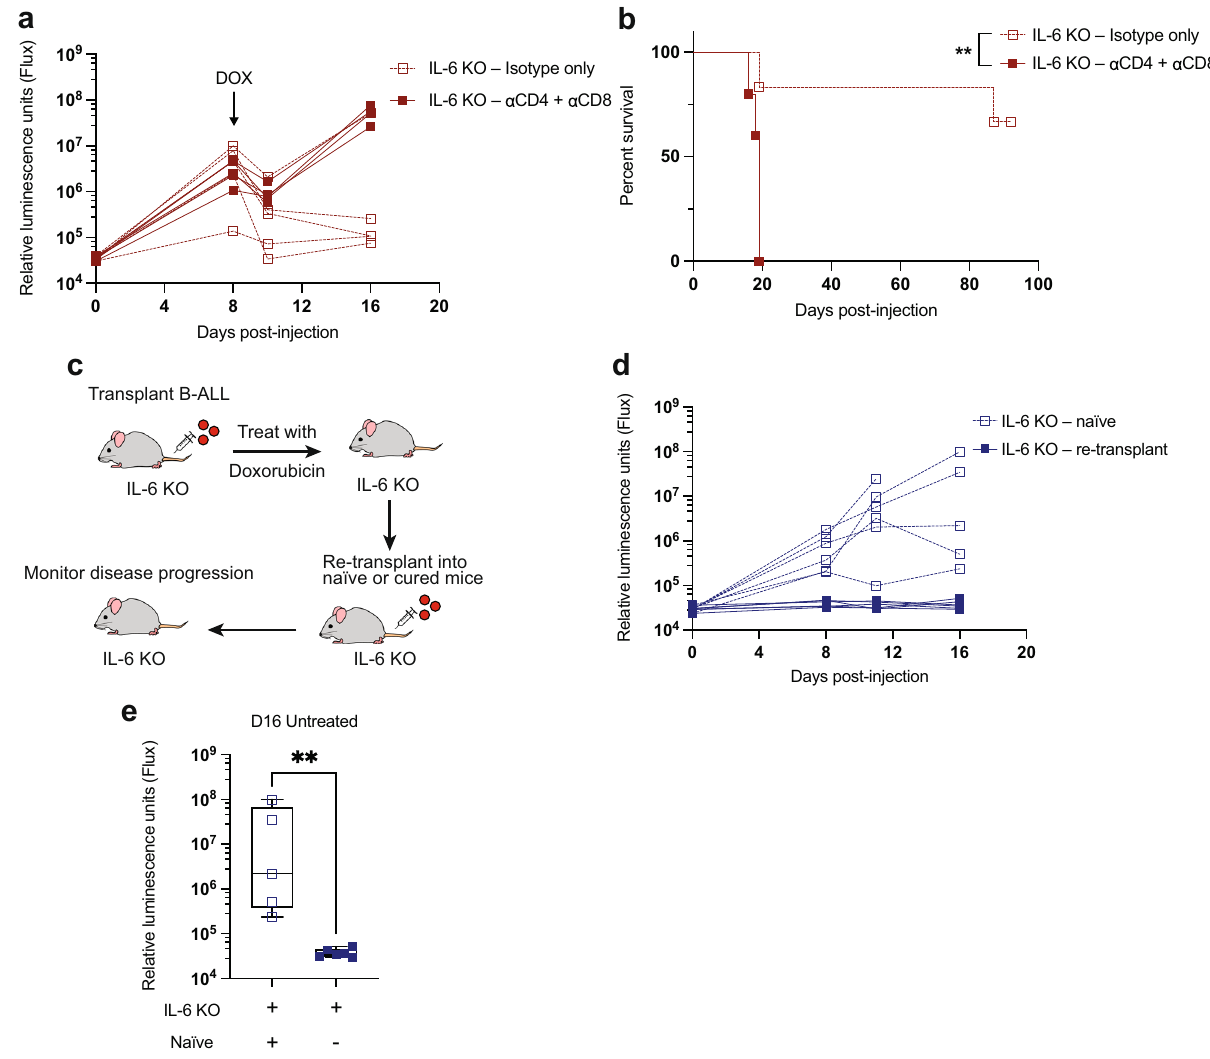
Fig. 4 T-cell-dependent anti-tumor immunity develops after doxorubicin treatment of IL-6 KO leukemic mice. a A graph showing leukemia burden in vivo monitored by bioluminescence imaging. CD4 and CD8 cells were depleted with antibodies and response to doxorubicin (DOX) treatment was followed. n = 5 per cohort. b A Kaplan – Meier survival curve showing leukemic IL-6 KO mice treated as in ( a ). n = 6 for IL-6 KO-isotype, n = 5 for IL-6 KO- depleted. ** p = 0.0059 by Log-rank (Mantel-Cox) test. c IL-6 KO mice previously cured (living > 80 days) by doxorubicin treatment were re-transplanted with leukemia cells and disease progression monitored by bioluminescence imaging in the absence of further treatment. d A graph showing leukemia burden in vivo in control and re-transplanted leukemia-bearing mice. n = 6 per cohort. e A graph showing leukemic IL-6 KO mice as in ( e ), D16 after disease transplant in the absence of treatment. At this time point, n = 5 for IL-6 KO-naive, n = 6 for IL-6 KO-re-transplant. ** p = 0.0043 by two-tailed Mann – Whitney test. Boxplots show the median as the center lines, upper and lower quartiles as box limits, and whiskers represent maximum and minimum values. D8 = Day 8, D16 = Day 16. Source data are provided as a ‘ Source data ’ fi de fi ciency appears to alter the bone marrow stroma to broadly (Fig. 5a). Combination treatment of WT B-ALL-bearing mice create a permissive immune microenvironment. with doxorubicin and PD-L1 antibody-blocking therapy reduced survival (Fig. 5c). These observations suggest that higher key roles in the suppression of anti-cancer immune responses are